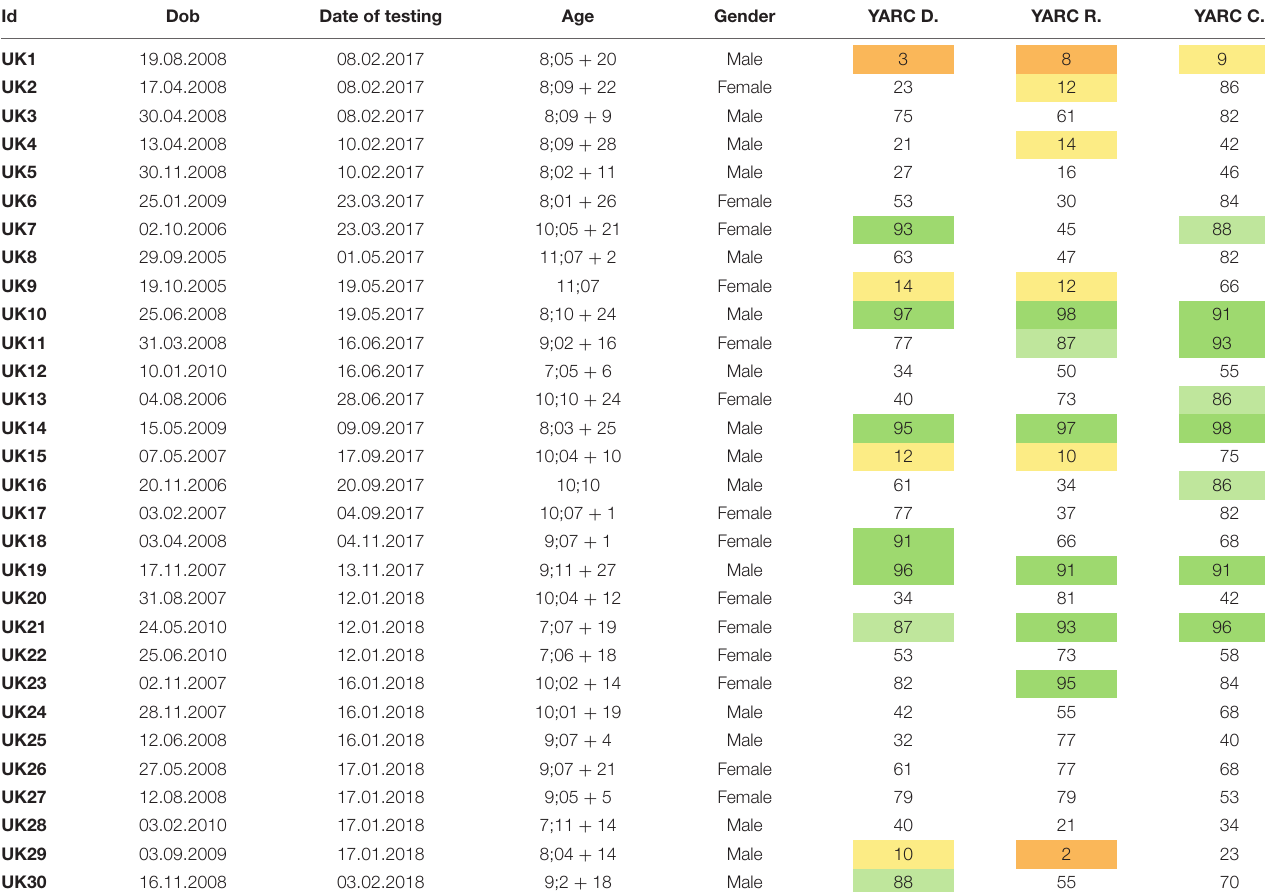
TABLE 2 | Individual percentiles in the three sections of the